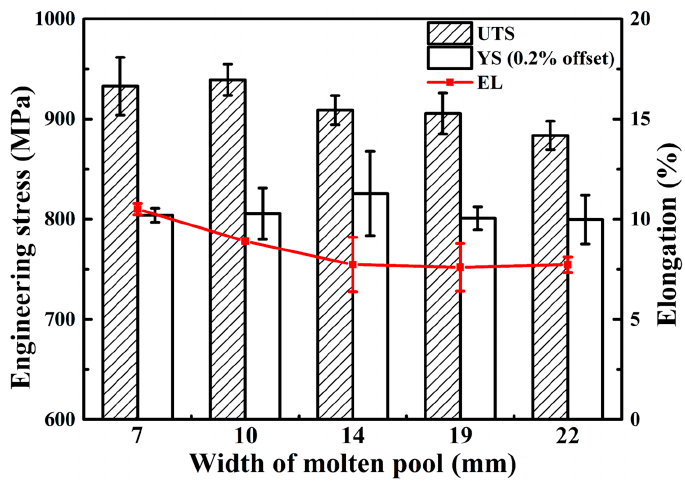
Figure 10. Tensile properties of samples deposited with WMP ranging from 7 mm to 22 mm.